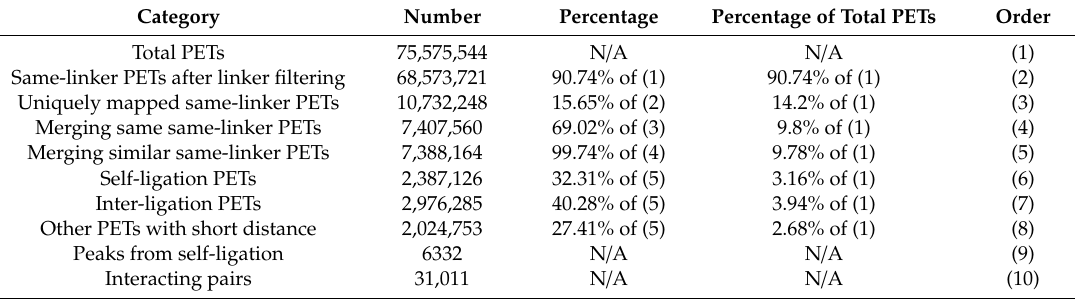
Table 4. Statistics of RNAPII ChIA-PET data from human K562 cells.